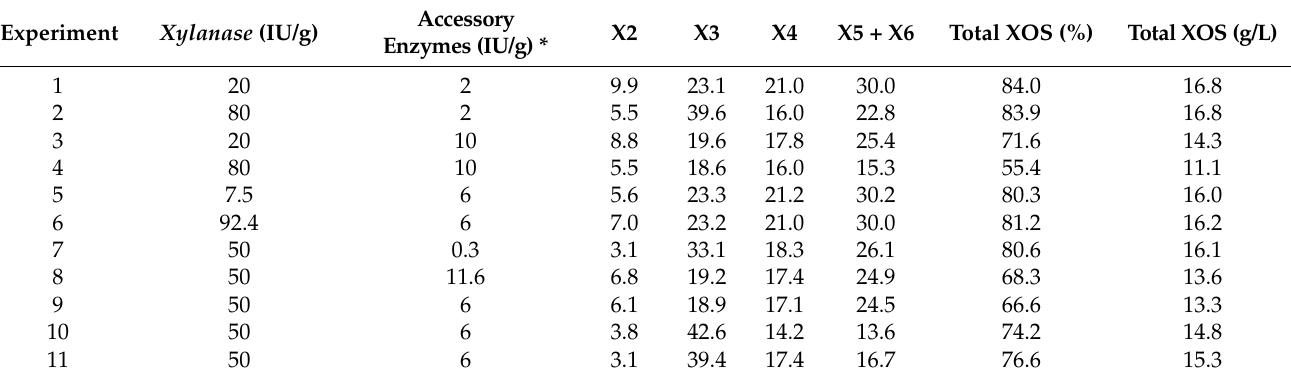
Table 2. Xylooligosaccharides production obtained through experimental design evaluating xylanase and accessory